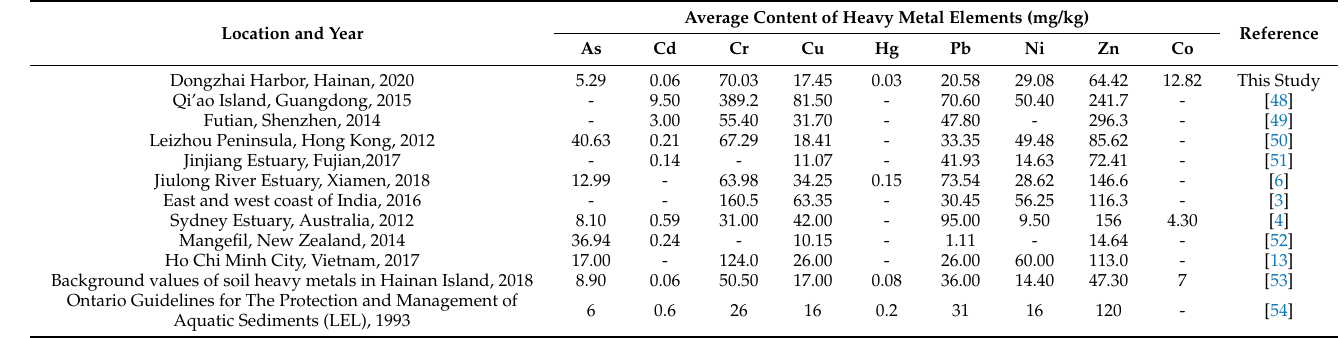
Table 4. Concentrations and quality standards of heavy metals in mangrove sediments worldwide.